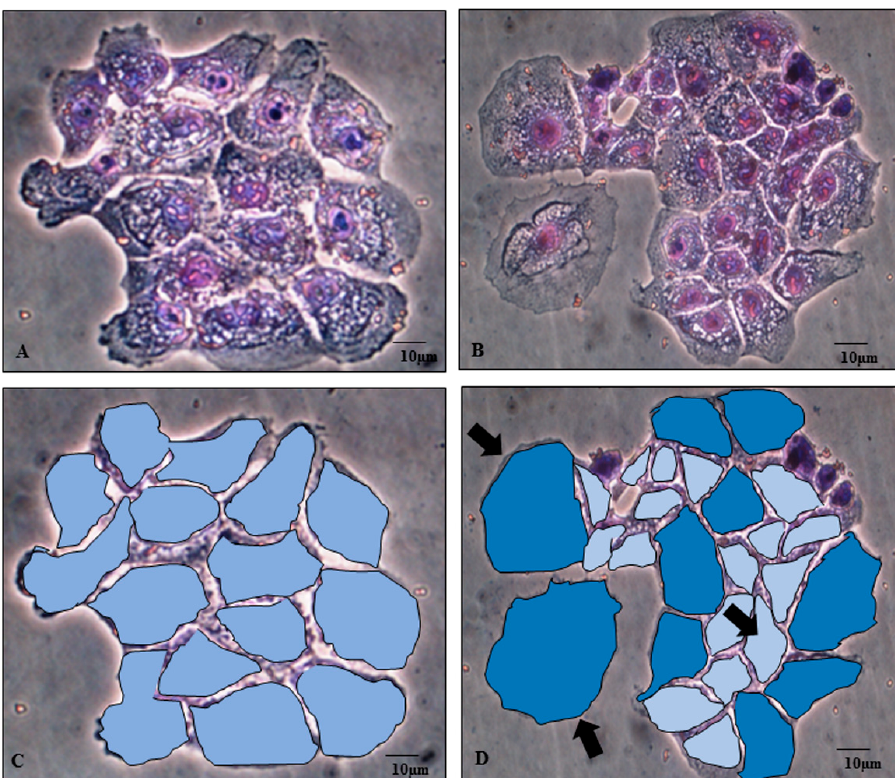
Figure 1. Microphotographs of MCF-10A by optical microscopy. MCF-10A cell line in the on-ground control condition ( A , C ) and exposed to microgravity ( B , D ) for 24 h. Magnification ×320. The images have been cut out ( C , D ) to highlight differences in both area and cell profile. Cropped images show that in microgravity, two distinct populations emerge (evidenced in blue and light blue), displaying different fractal dimension and roundness values, as reported in Table 1. Scale bar 10 µm.